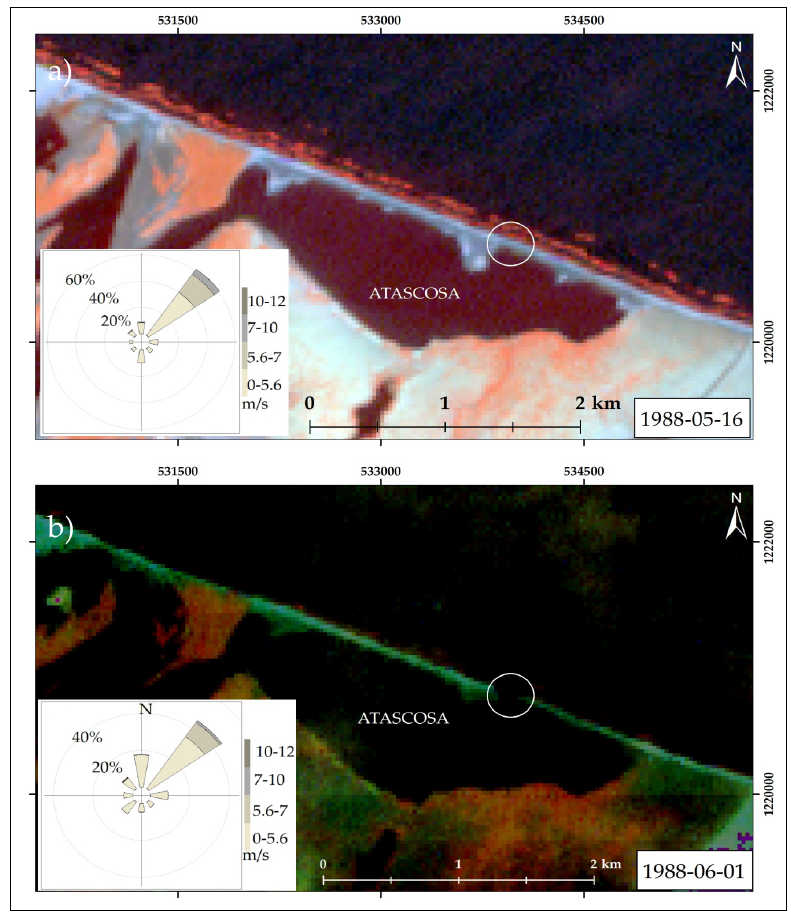
Figure 6. Breaching process for Atascosa lagoon in May–June 1988. ( a ) The last image with no breach was taken on 16 May 1988. ( b ) The first image of the breach was taken on 1 June 1988. Wind roses indicate wind conditions two weeks prior to image acquisition. Landsat 4 images courtesy of U.S. Geological Survey. Images displayed combining bands 754.